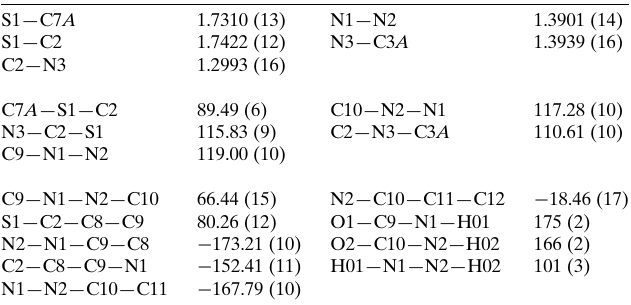
Table 1 Selected geometric parameters (A˚ , (cid:2) ).